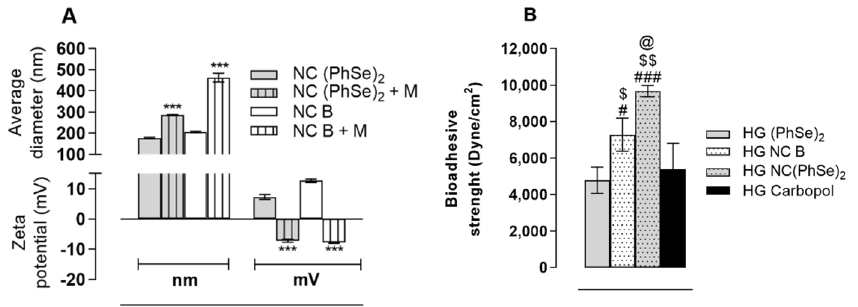
Figure 3. Effect of mucin (+M) treatment on the average diameter and zeta potential of nanocapsules ( A ) and the mucoadhesion strength of hydrogels ( B ). The statistical evaluation was performed by paired Student’s t ( A ) or one-way ANOVA followed by Tukey. (***) p < 0.001 denotes statistical difference between initial and after mucin exposure values of average diameter and zeta potential; # denotes statistical difference in comparison to HG (PhSe) 2 ; (#) p < 0.05 and (###) p < 0.001; $ denotes statistical difference in comparison to HG Carbopol; ($) p < 0.05 and ($$) p < 0.001; @ denotes statistical difference between NC (PhSe) 2 and NC B; (@) p < 0.05.